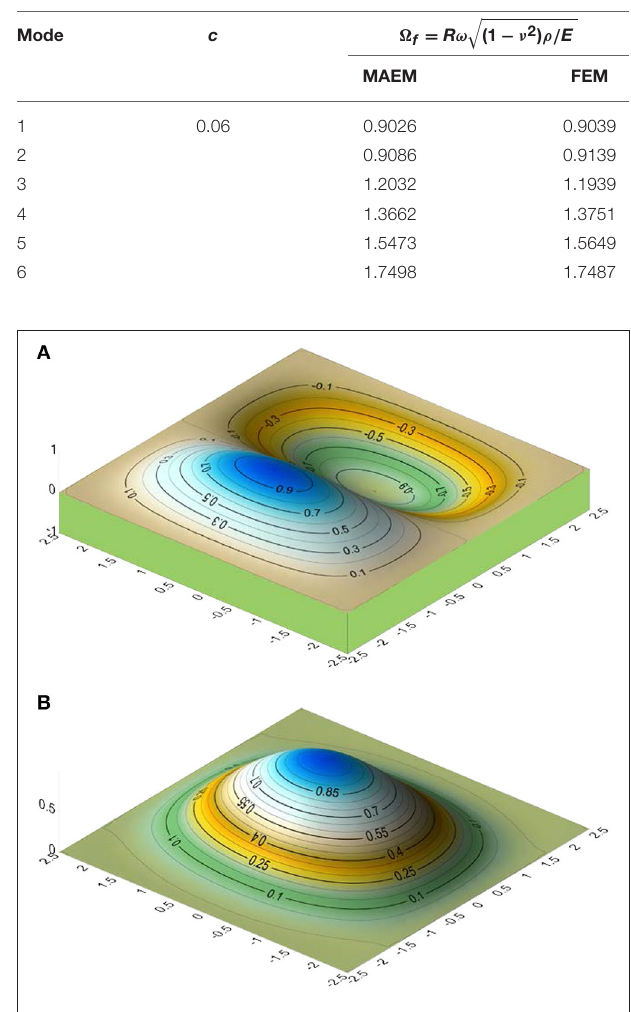
FIGURE 6 | (A) 1st vibration mode of the shell in Example 2. (B) 2nd vibration mode of the shell in Example